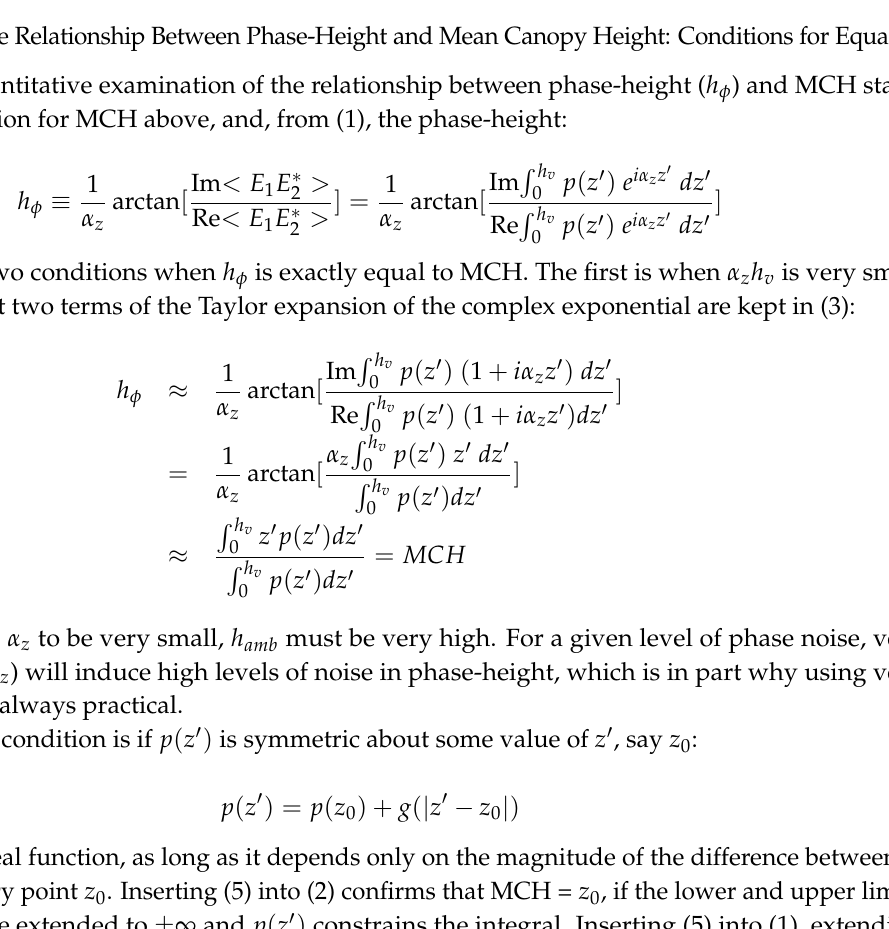
Figure 3. A graphic representation of the integral in (1) for a 3-thin-layer radar power profile. The ntegral is a sum of the three black vectors in the complex plane, each with amplitude equal to the power of the layer, and phase proportional to the altitude of the layer. The red vector is the total, the value of the integral in (1). The phase-height corresponding to this red vector, φ int / α z , is between that of the lowest and the highest